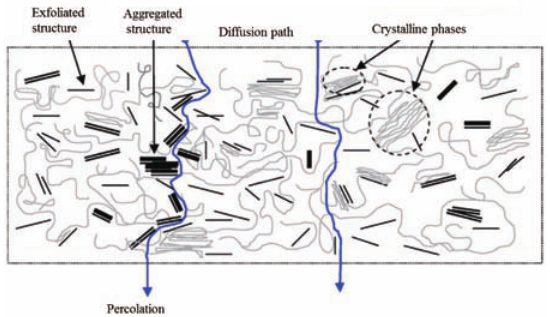
Fig. 6 Illustration of diffusion of water through clay- polymer nanocomposites (Alexandre et al.,